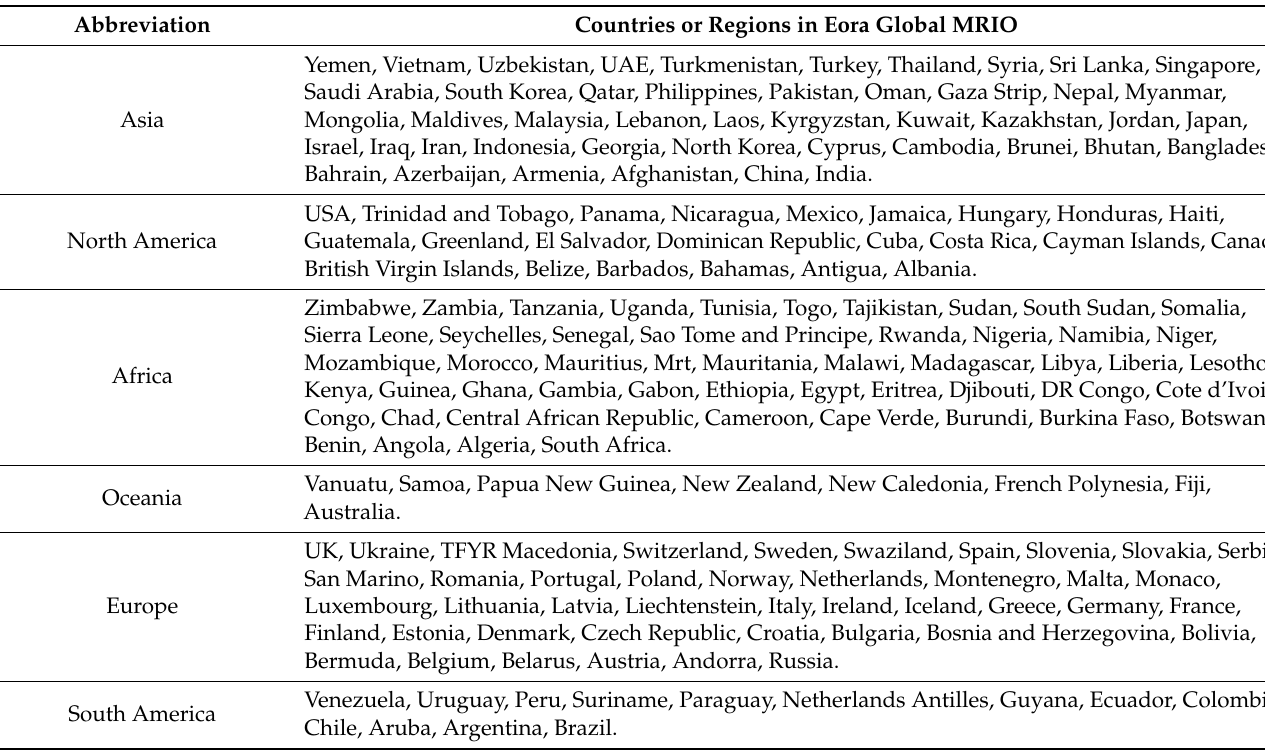
Table 2. Classification of